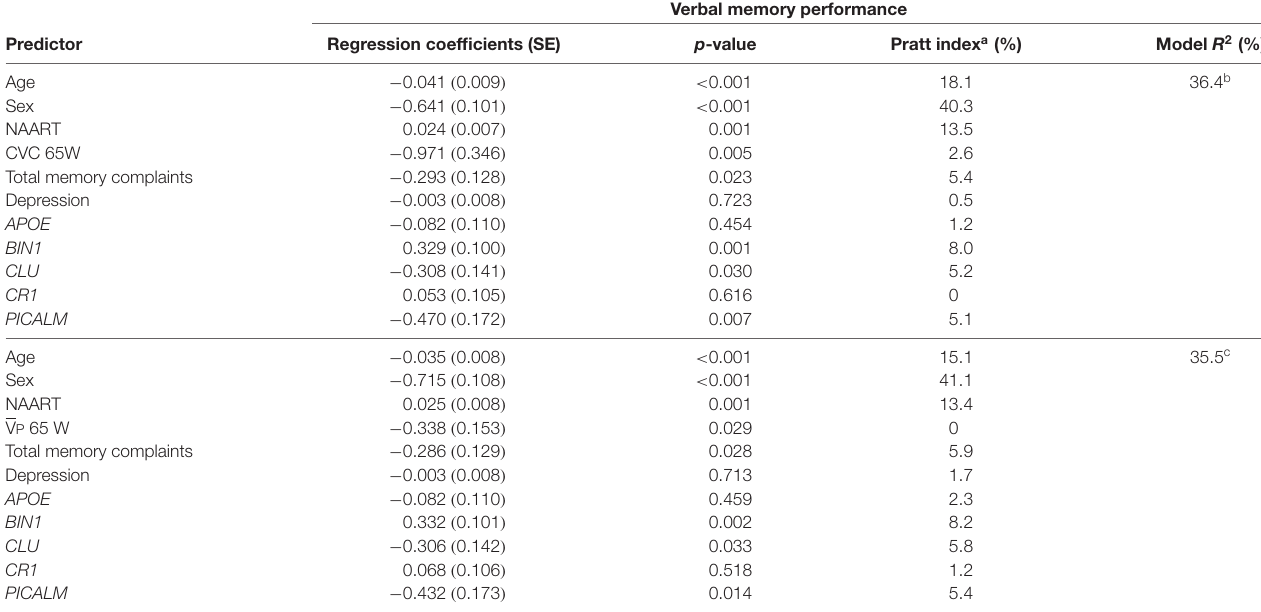
TABLE 4 | Results from multiple regression analysis and relative contribution of predictors of verbal memory performance in BIM Study participants using total memory complaints.